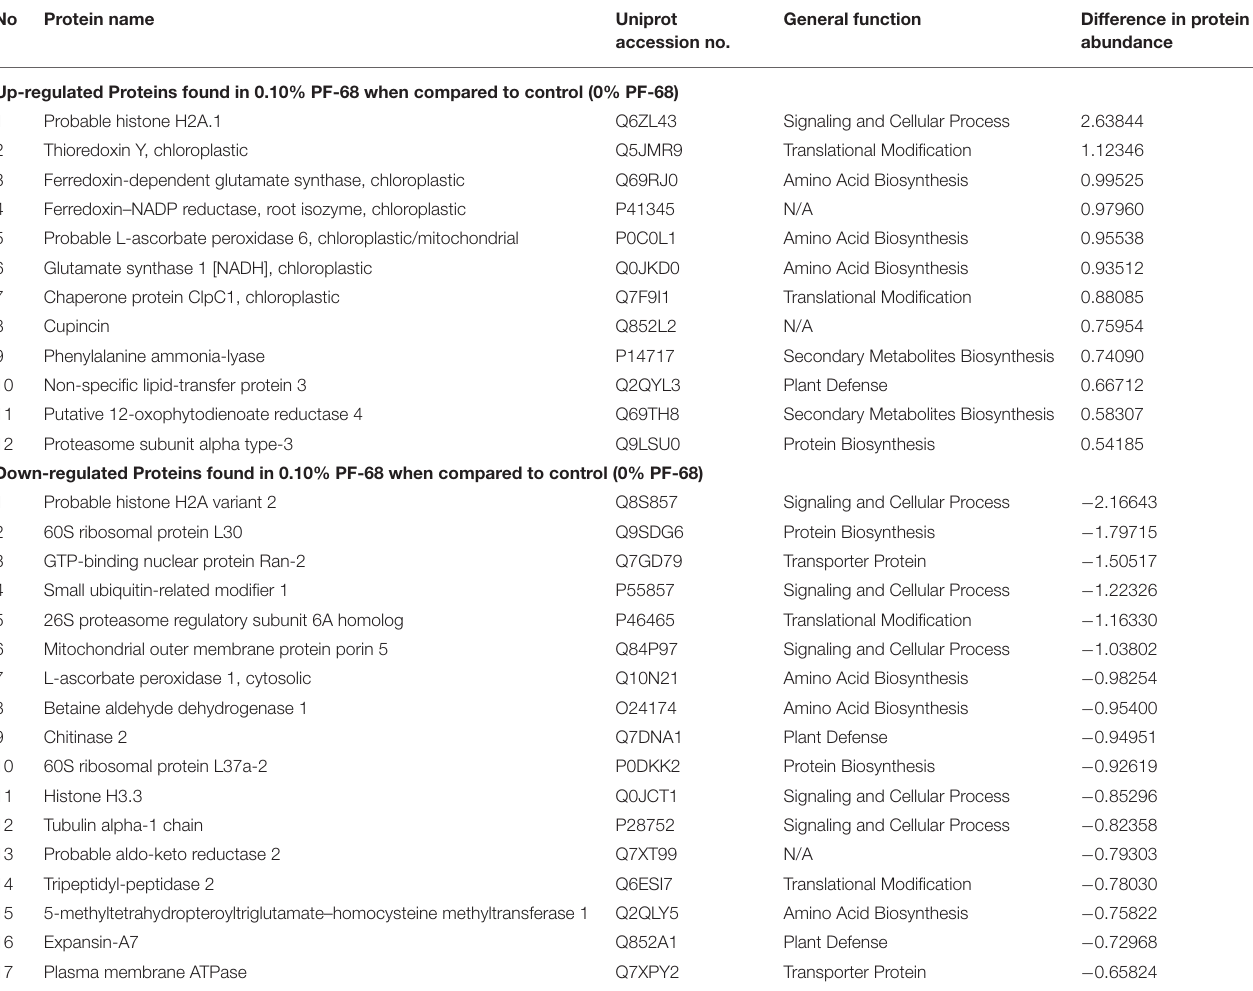
TABLE 3 | Top 20 proteins showing significant abundance difference (together with their accession numbers) when compared between control and high PF-68 concentrations. No Protein name Uniprot